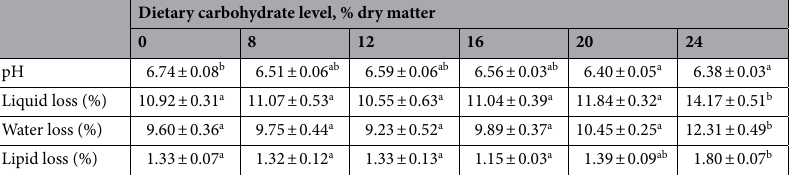
Table 1. The pH and liquid holding capacity (LHC) in the muscle of olive flounder after a 10-week feeding trial. All data were expressed as mean ± SE. Mean values within the same row with different superscripts are significantly different ( P < 0.05; Tukey’s